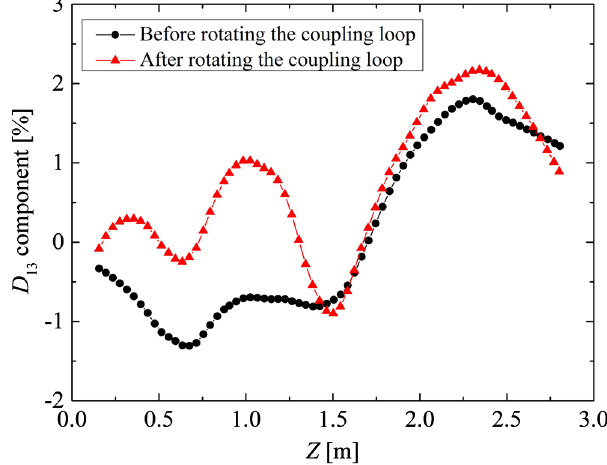
FIG. 11. D 13 field component before and after rotating the coupling loop by 5.1°.